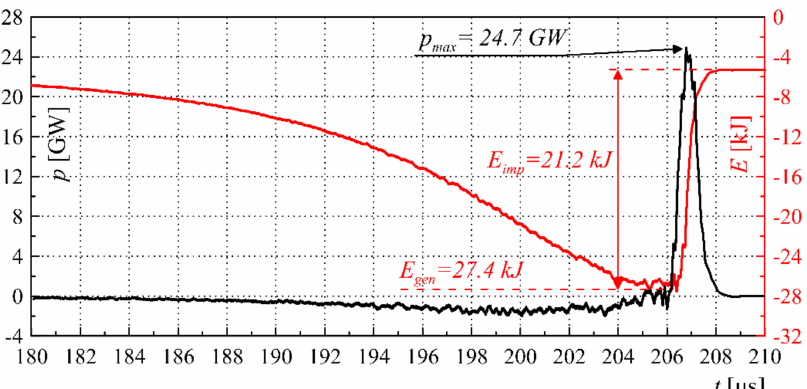
Figure 17. Waveforms of instantaneous power p (black) and energy E (red) generated by the integrated high-power pulse generation and forming system during its operation with characteristic values marked—experimental results: p max —maximum pulse power value, E gen —energy generated during the FCG operation, E imp —energy of the formed pulse.